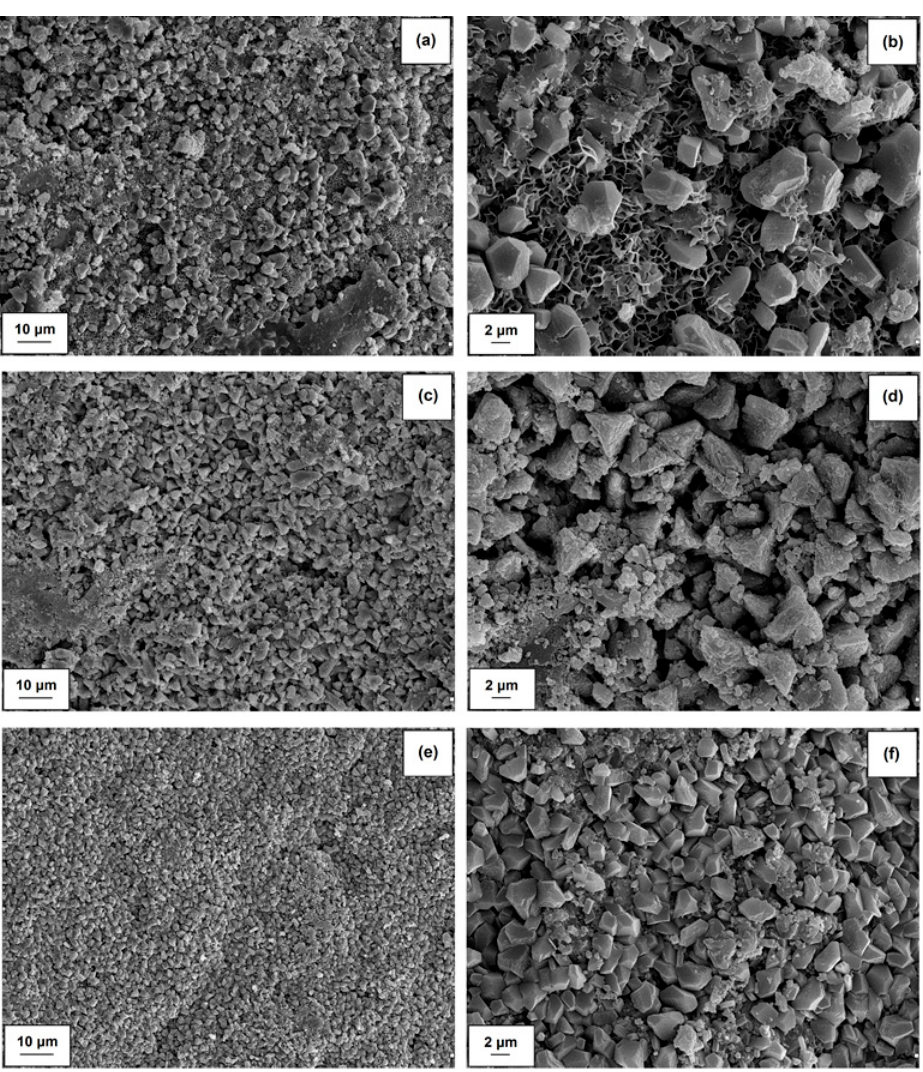
Figure 7. SEM images of samples after compressive strength tests for cement mortar ( a, b ), Al 2 O 3 -LS ( c, d ) and Al 2 O 3 -LIG ( e, f ) hybrid